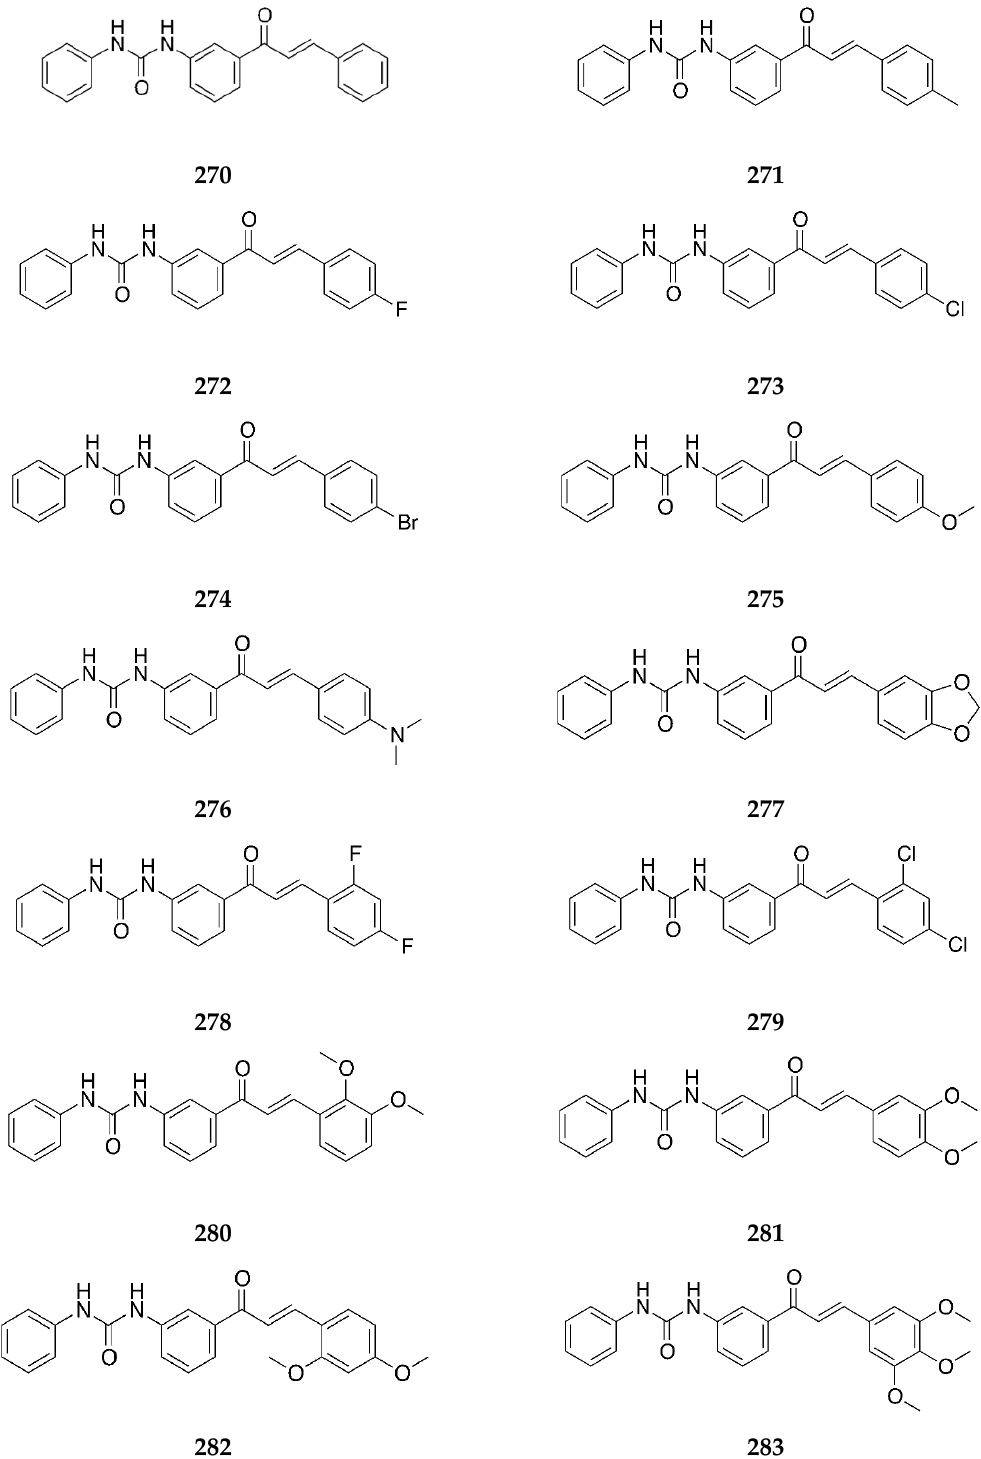
Figure 74. Chemical structure of N -acyl-3-aminochalcone derivatives with substitution on ring B.